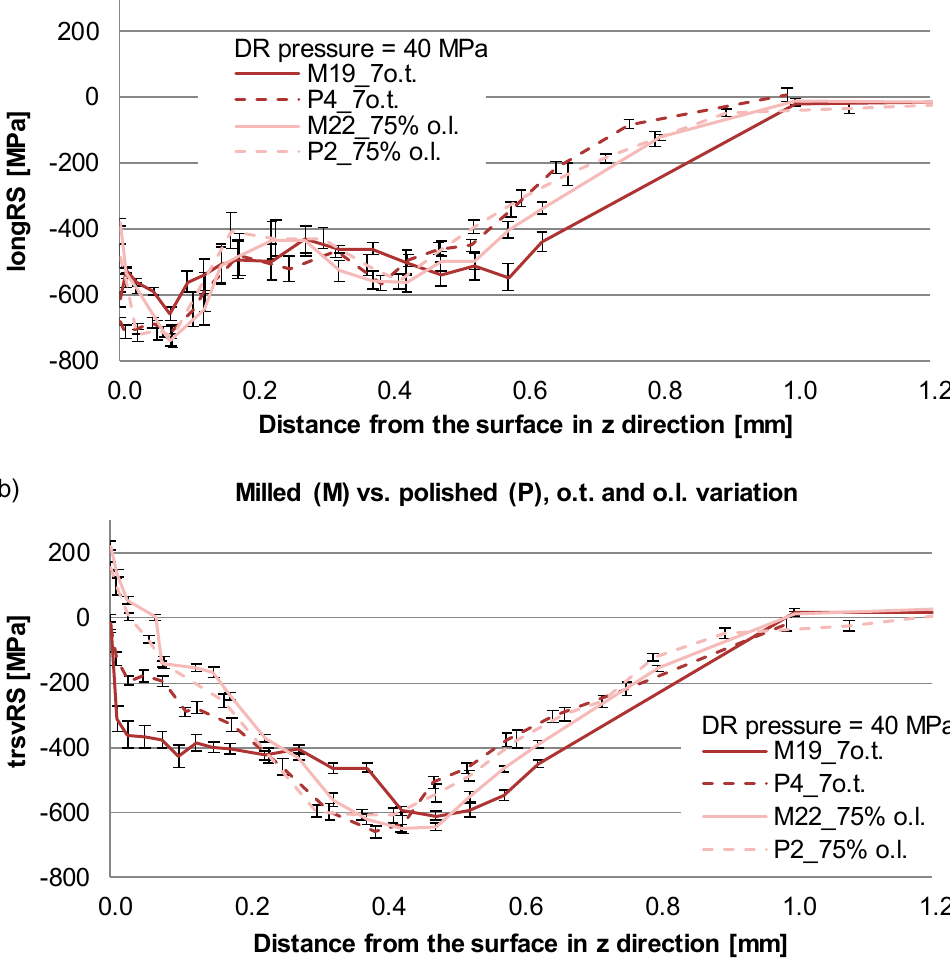
Figure 9. Residual stress depth distribution (measured with Seifert) after DR by different pre-machining states, i.e., milled and DR (designation “M”) or milled, polished and DR (designation “P”), overturn (o.t.) and overlapping (o.l.) variation; ( a ) longitudinal residual stresses (longRS) and ( b ) transverse residual stresses (trsvRS).